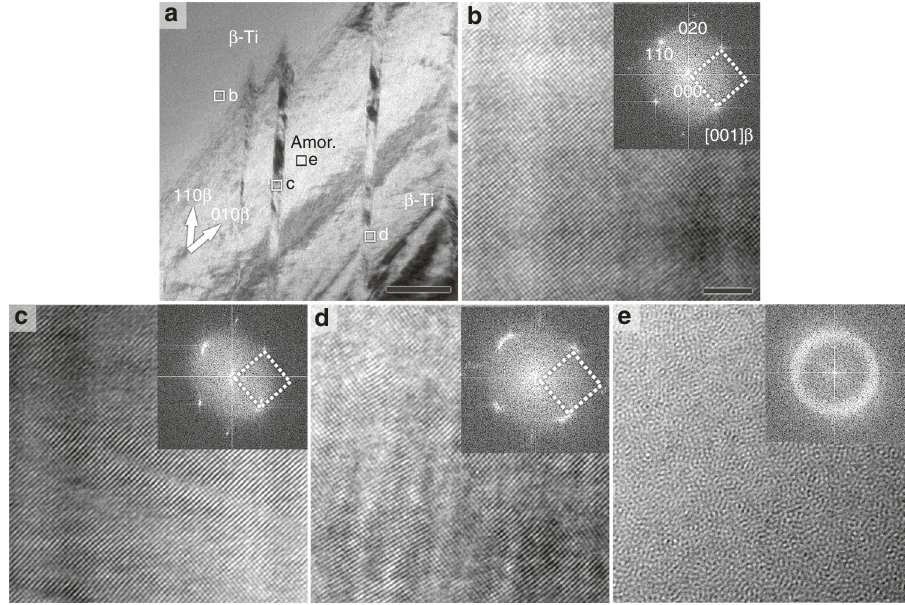
Fig. 2 Detailed microstructure of an as-cast Ti 59.1 Zr 37 Cu 2.3 Fe 1.6 rod with a diameter of 8 mm. a The bright- fi eld TEM micrograph exhibits a representative lenticular region containing shear steps inside the β -Ti grain. The strips are parallel to < 111 > β , which corresponds to < 110 > β when the crystal is viewed along [001] β . b – e HRTEM images taken from those regions marked b – e in a , respectively, with insets of the corresponding FFT images. b The matrix surrounding the lenses consists of unstrained β -Ti. c , d The FFT spots split, indicating a highly distorted β phase. e The maze-like pattern and the halo in the FFT image imply the presence of an amorphous phase. The scale bar in a represents 100 nm, and the scale bar in b 2 nm, which also applies to c –